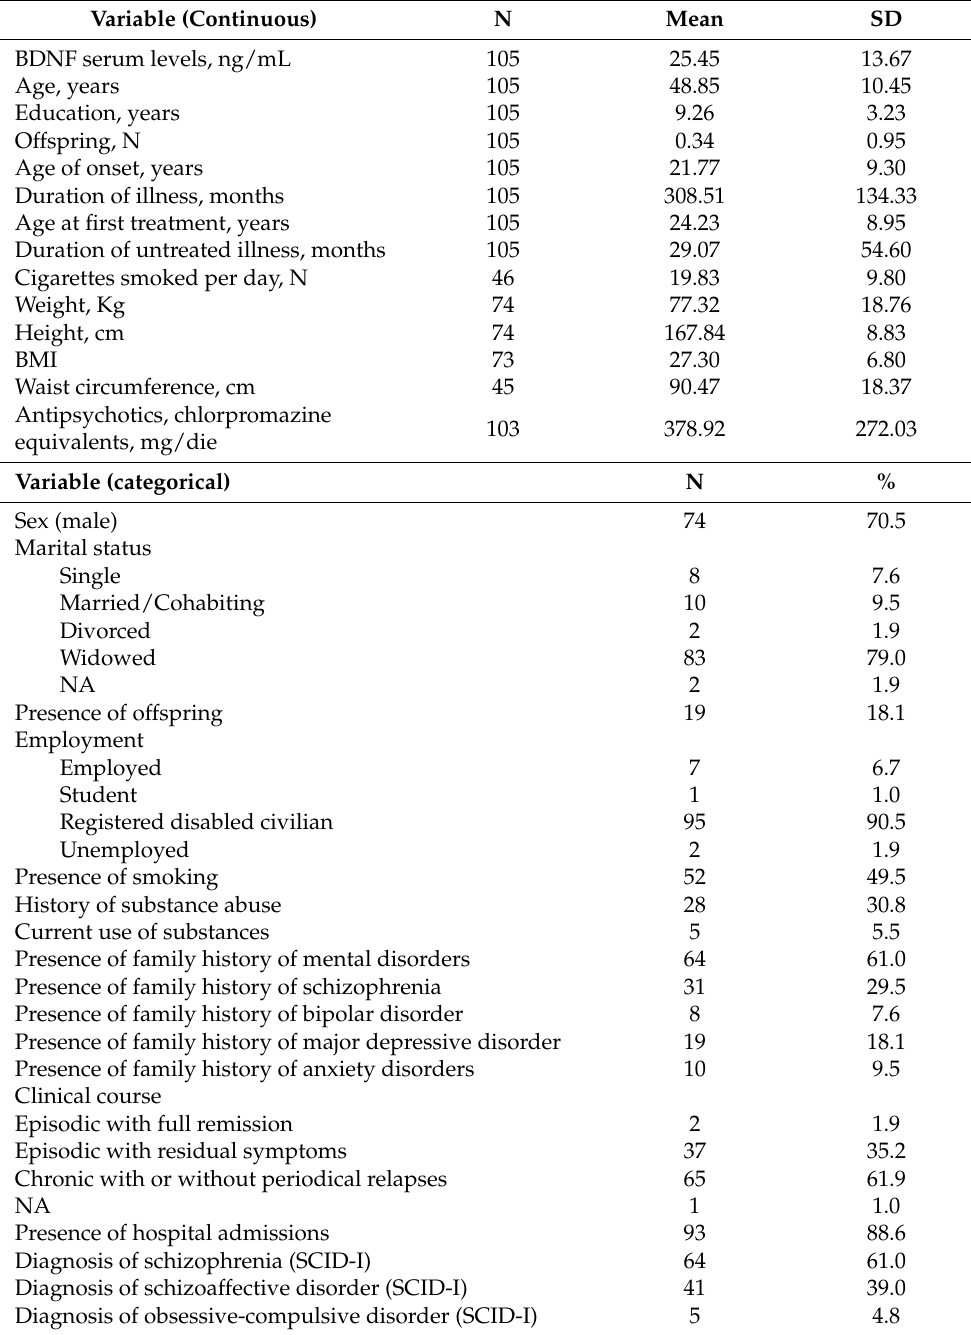
Table 1. Demographic and clinical characteristics of 105 patients with schizophrenia and schizoaffec- tive